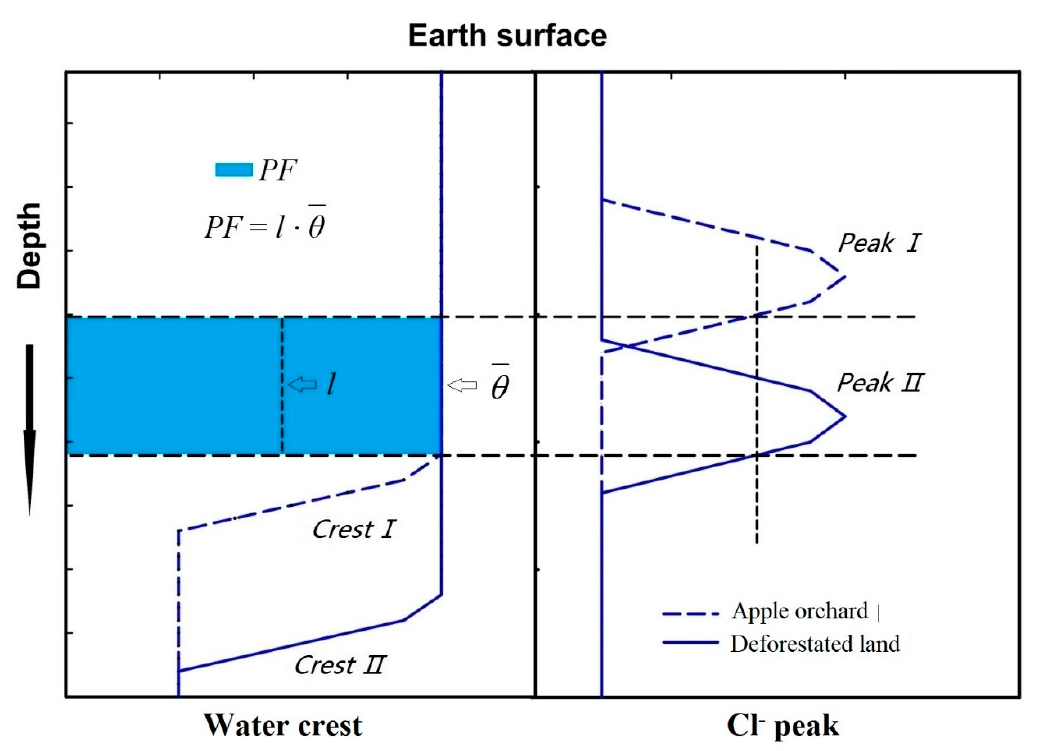
Figure 2. Diagram of water movement accompanying Cl − .